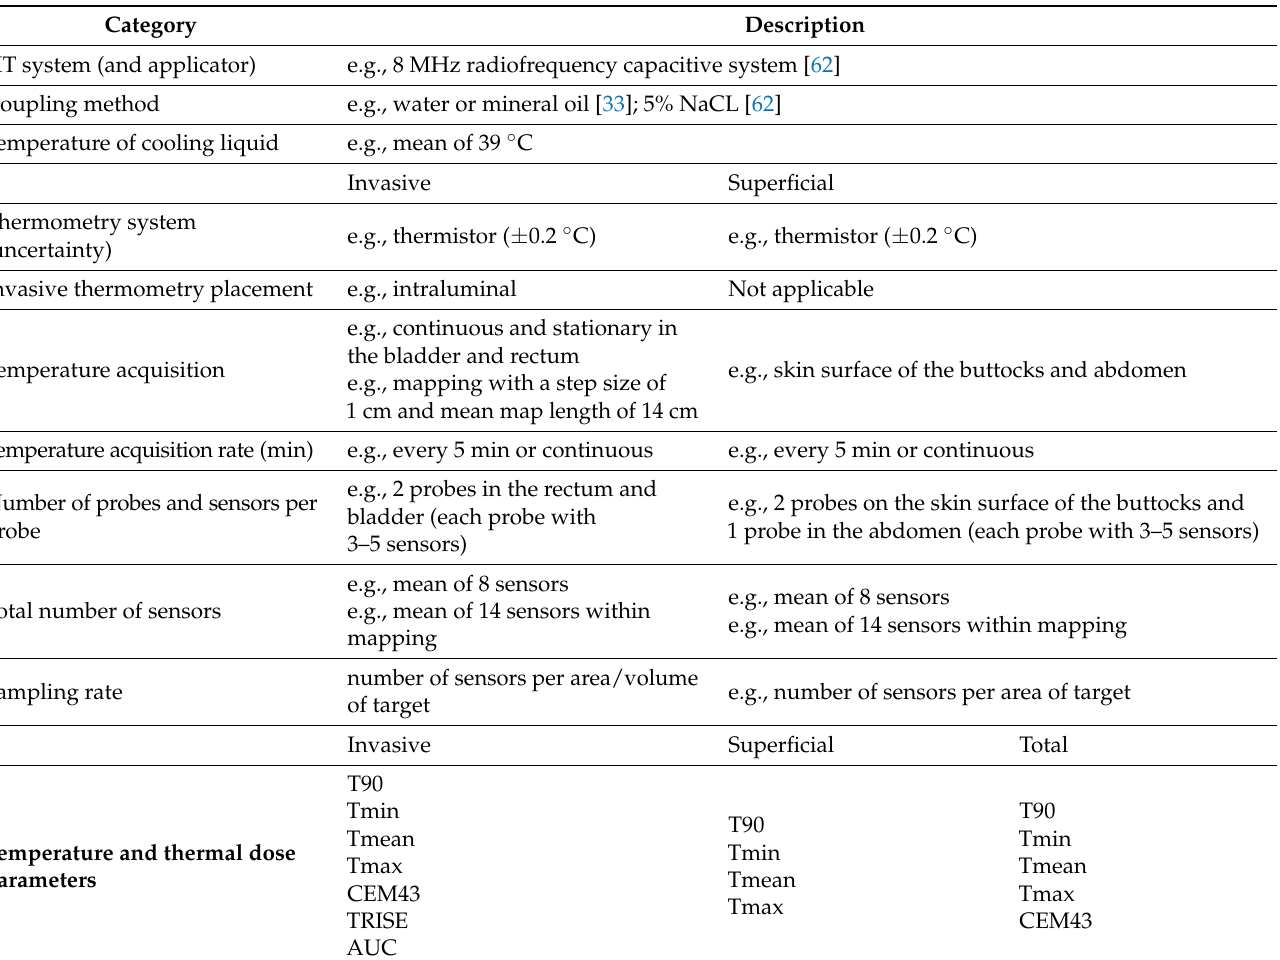
Table 3. Template to report HT system and thermometry characteristics, as well as temperature and thermal